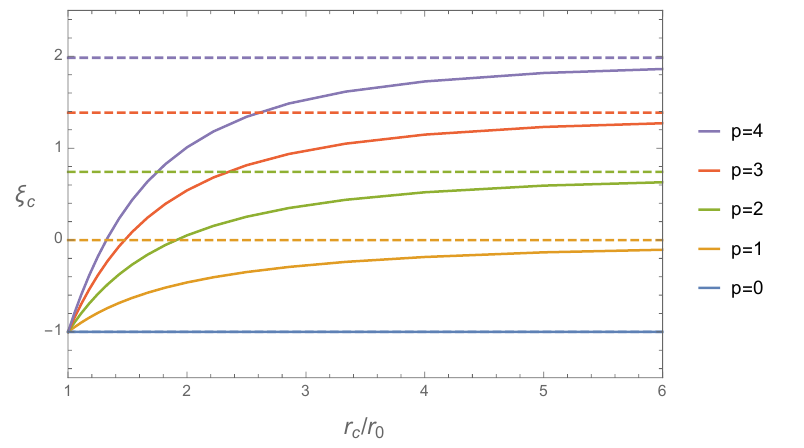
Figure 2 . The momentum relaxation rate (cid:28) (cid:0) 1 of the cuto(cid:11) surface r c . The black solid lines indicate that at the leading order the formula (cid:28) (cid:0) 1 is independent of the cuto(cid:11) scale r c =r 0 . However, the dashed lines indicate the r c dependence of 4 (cid:25)T c (cid:28) (cid:0) 1 , with the sub-leading contributions in (4.2). Roughly, from top to down p = 0 ; 1 ; : : : ; 4. c k 2